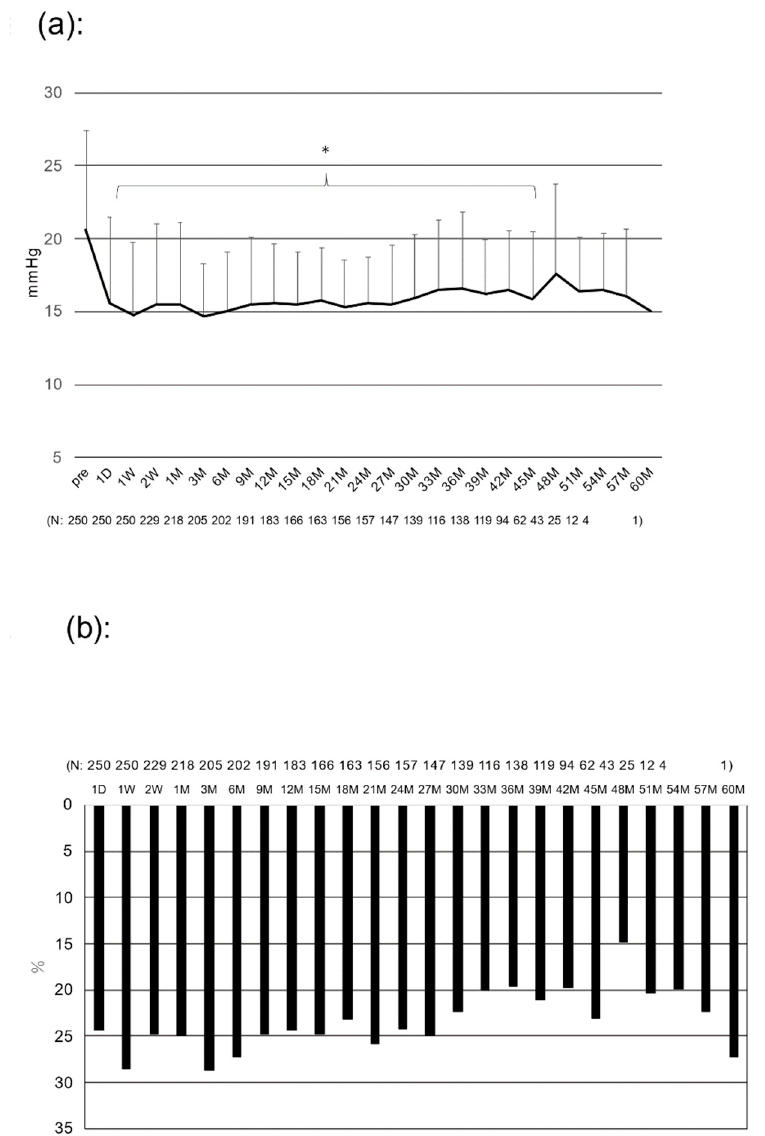
Figure 1. Postoperative changes in IOP and IOP reduction rate: ( a ) postoperative changes in IOP, * p < 0.05 vs. preoperative value (repeated ANOVA), ( b ) postoperative IOP reduction rate. Bar = SD.